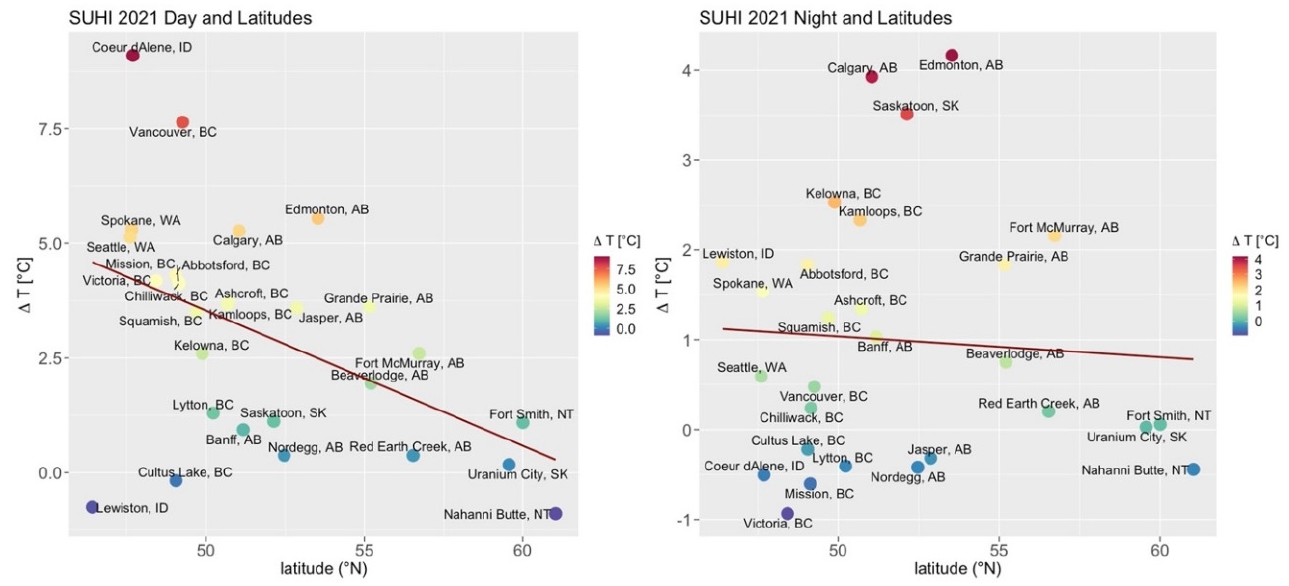
Figure 1. SUHI intensity ( ∆ T) vs. latitude for 28 cities (Table 1) during the 2021 HW at daytime ( left ) and nighttime ( right ).